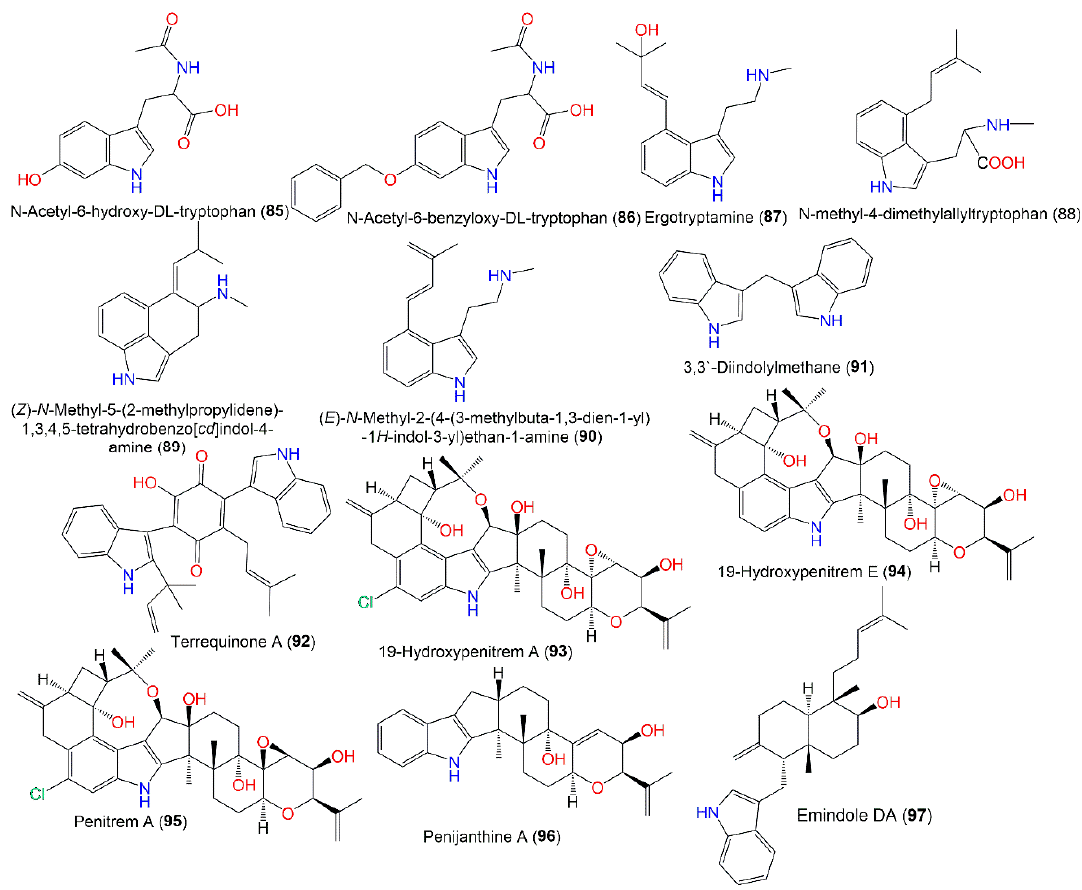
Figure 8. Structures of indole ( 85 – 97 ) alkaloids.